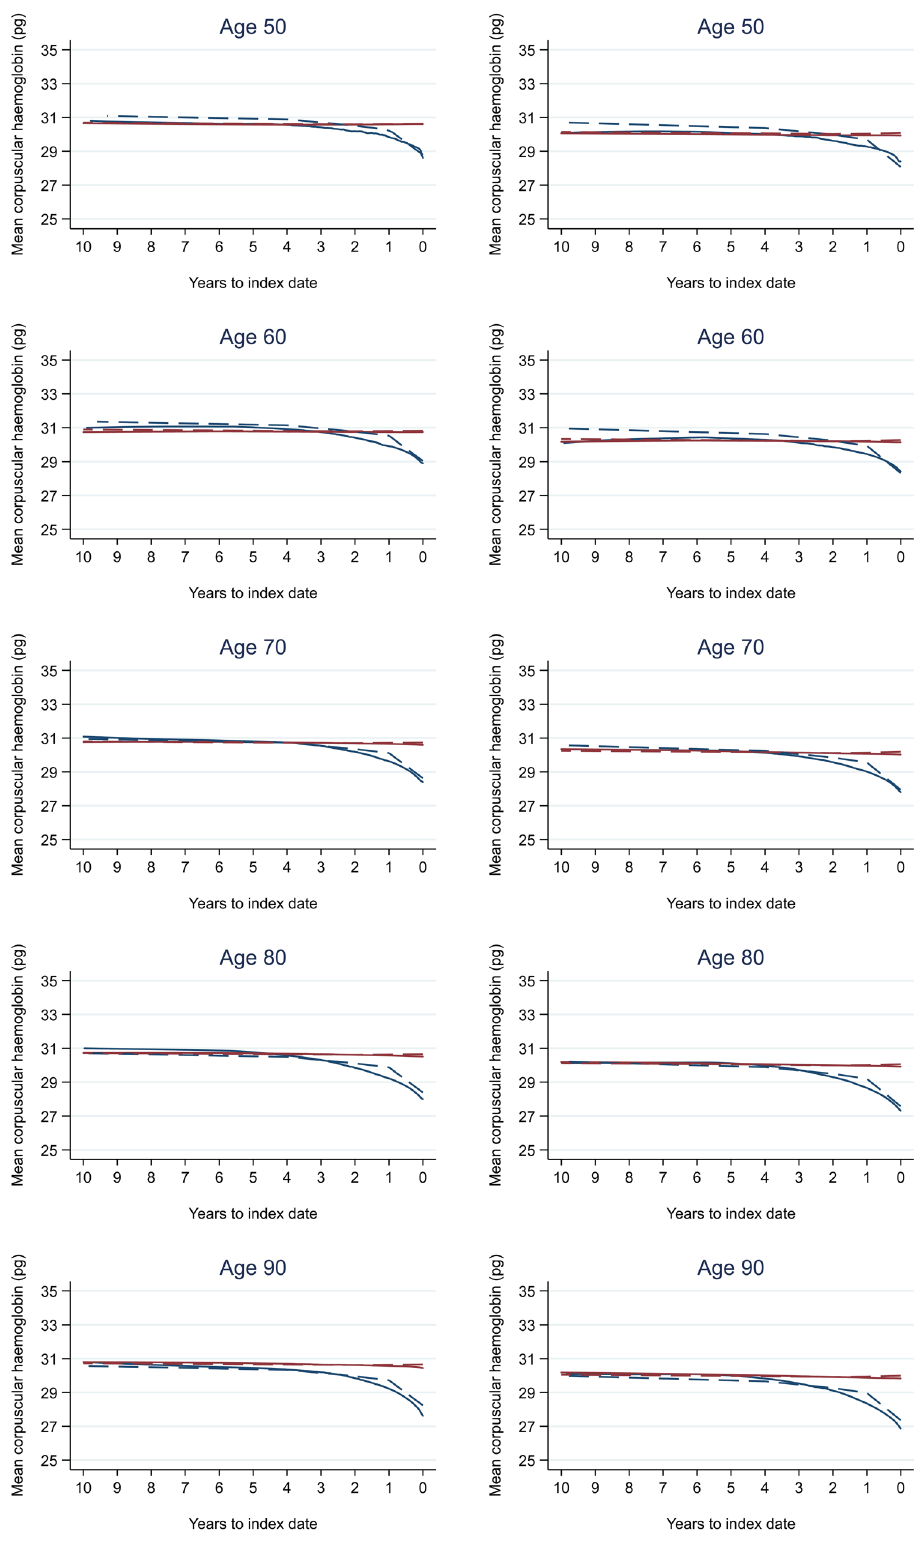
Figure 8. Mean corpuscular haemoglobin trends between cases and controls, by age at index date 1,2 . 1 Index date was the date of diagnosis for cases and a randomly selected date in the patient’s study period for controls. 2 LOWESS trends are age (+/- 3 years) and modelled (fixed effects) trends are taken at that specific age. Legend: males (left) and females (right). Colorectal cancer (blue line) and no cancer (red line). LOWESS trend (solid line) and modelled trend (dashed line).